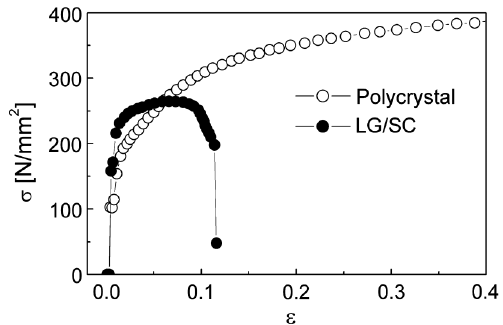
FIG. 9. Biaxial bulge test results on a large grain Nb sample. The curve for the polycrystalline sample is shown as reference.